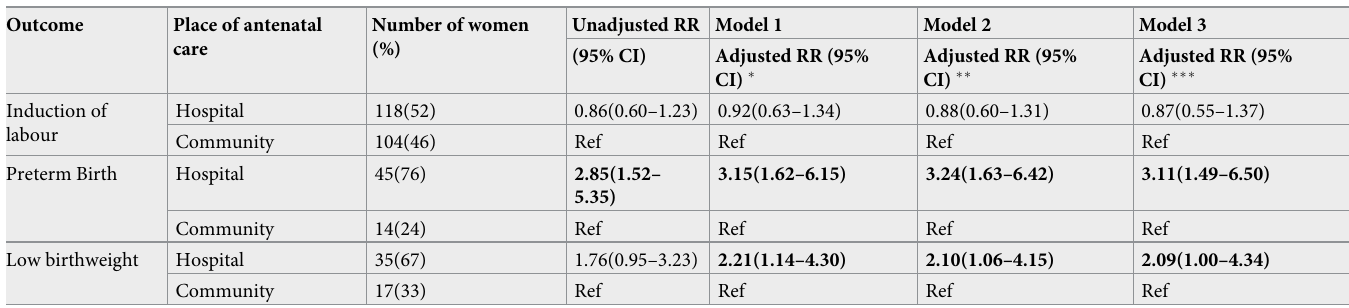
� Model 1: Adjusted for demographics ethnicity, age, parity, IMD score, social risk and medical risk factors. �� Model 2: Model 1 plus adjusted for model of care. ��� Model 3: Model 2 plus Adjusted for service provider